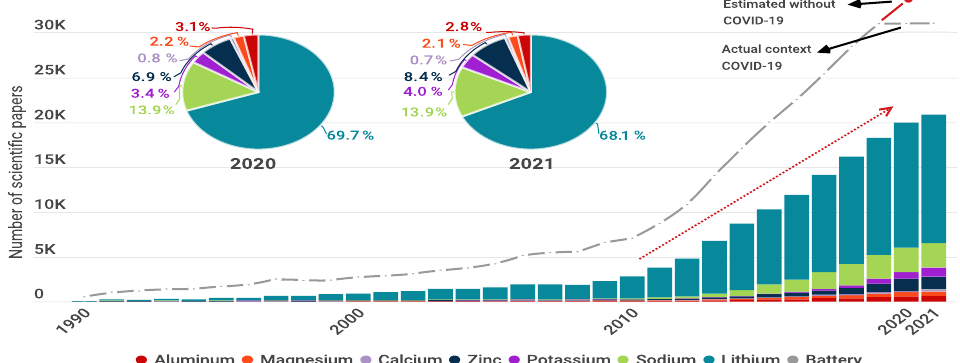
Figure 1. Number of publications per year including words “Aluminum Battery”, “Magnesium Battery”, “Calcium Battery”, “Zinc Battery”, “Potassium Battery”, “Sodium Battery”, and “Lithium Battery”. The gray line represents the number of publications per year including “Battery” or “Batteries”. The pie charts show the percentage of publications in the years 2020 and 2021. Graph constructed by the authors. Data from Web of